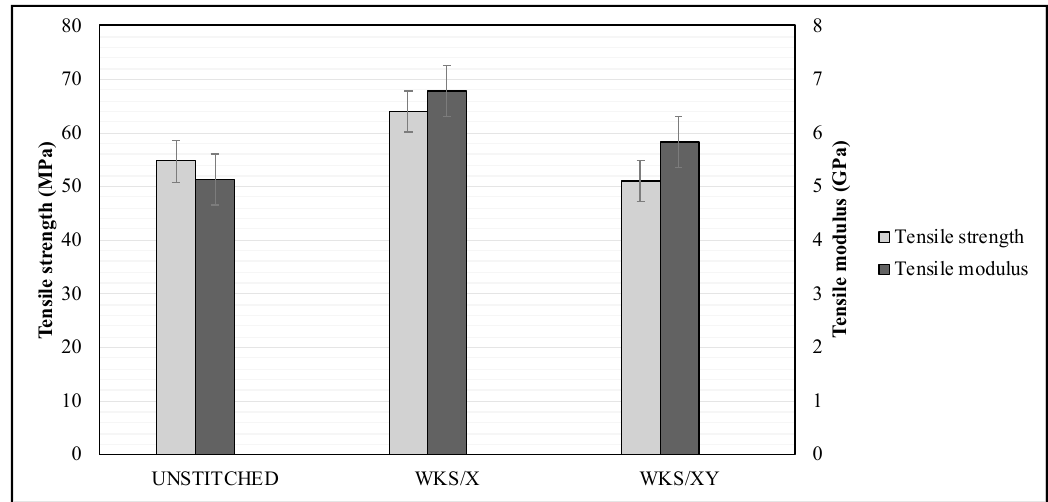
Figure 11. Effect of stitching density and pattern on the tensile properties of the unstitched and silk-fiber-stitched woven kenaf composites.